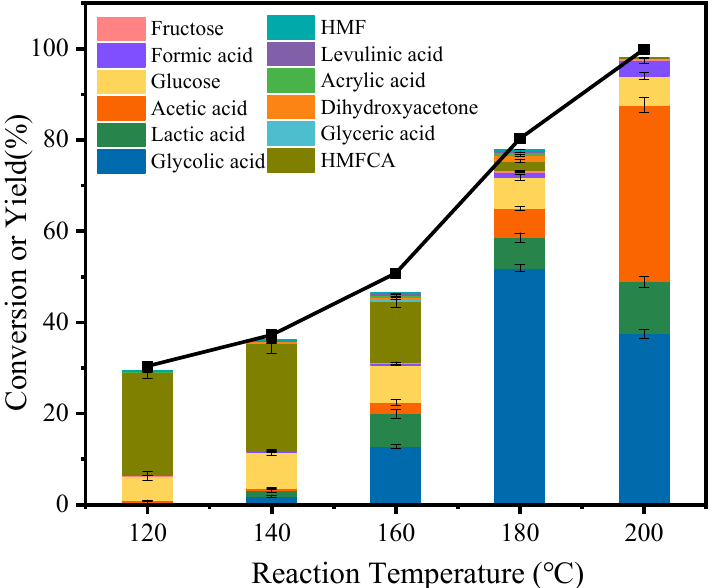
Figure 9. The effect of reaction temperature on the catalytic activity of Bi/ β -2 catalyst. Reaction conditions: cellulose 0.1 g, Bi/ β -2 0.08 g, H 2 O 12 mL, 10 h, 2 MPa O 2 .